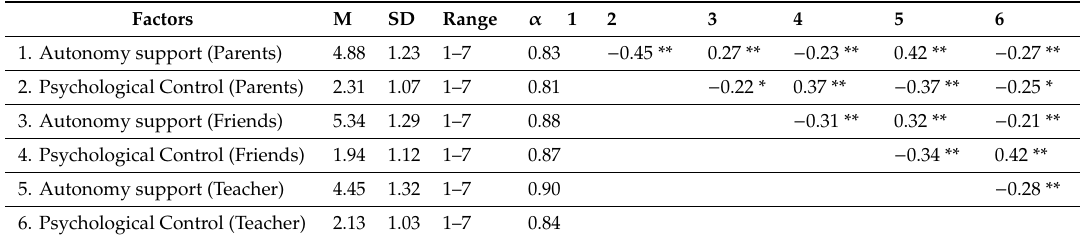
Table 1. Descriptive statistics, internal consistency analysis and bivariate